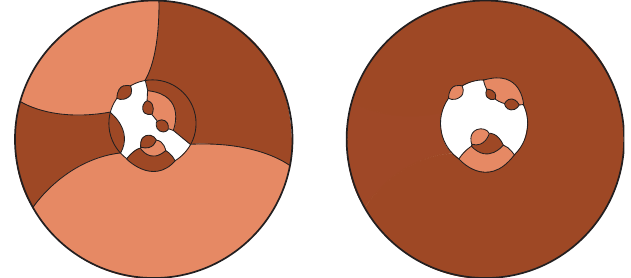
Figure 6.3 . The generating curve for a nonstandard area-minimizing double bubble in which the exterior does not intersect the axis of revolution. The bubble’s graph structure has at most one cycle, whose nodes correspond to regions intersecting the axis. If this cycle is nontrivial (left), then each region in the cycle is a topological sphere with trees of toroidal bands attached. If the cycle is trivial (right), then the region intersecting the axis is a topological torus with trees of toroidal bands